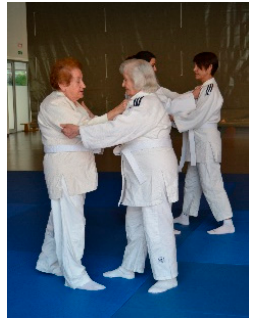
Figure 6. Movements, working in pairs.